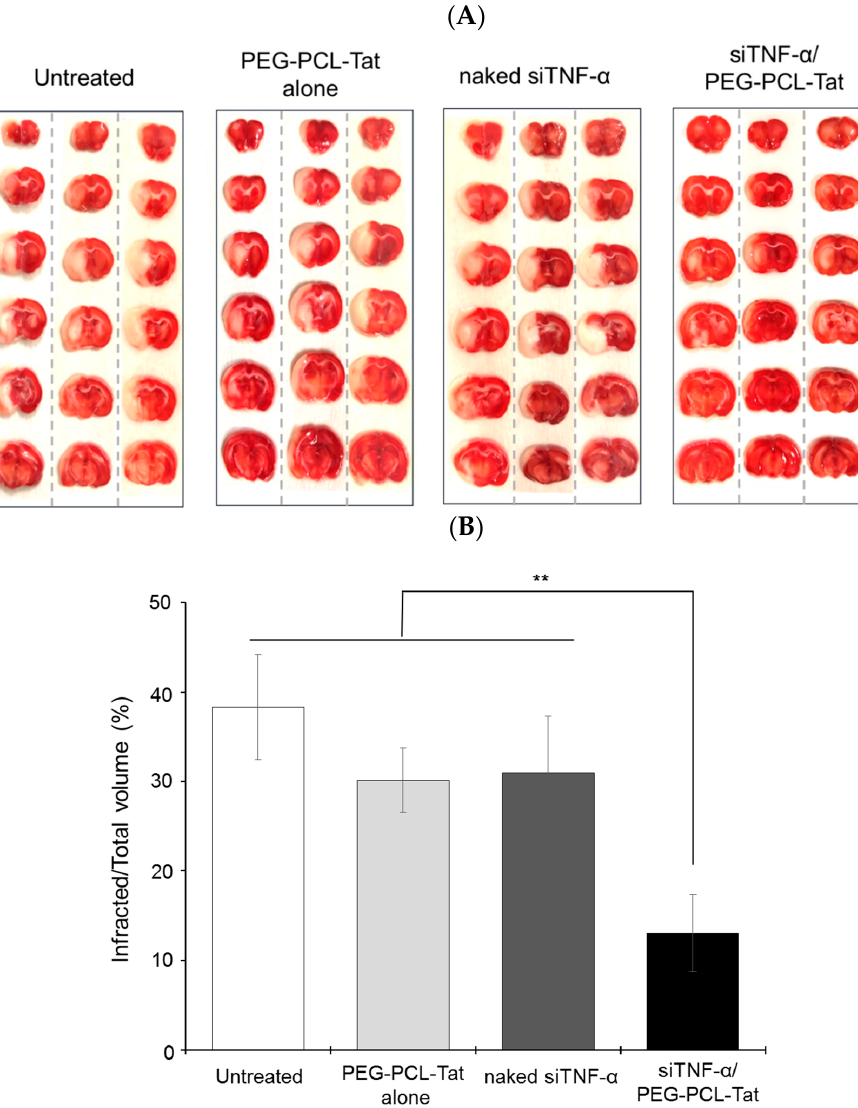
Figure 3. The representative Images of the TTC staining of continuous coronal brain slice and infracted area (%) in MCAO rats treated with intranasal administration of siTNF- α / PEG-PCL-Tat complex. ( A ) Each brain from MCAO rats in each treating group was isolated, and each isolated brain was sliced in the coronal direction at 2-mm intervals. The continuous coronal brain slice sections were stained with a 2% TTC solution. ( B ) The infracted area (%) for a total area of 6 continuous coronal brain slices were calculated using the Image J image analysis program. Each bar represents the mean ± S.E. ( n = 5). ** p < 0.01.